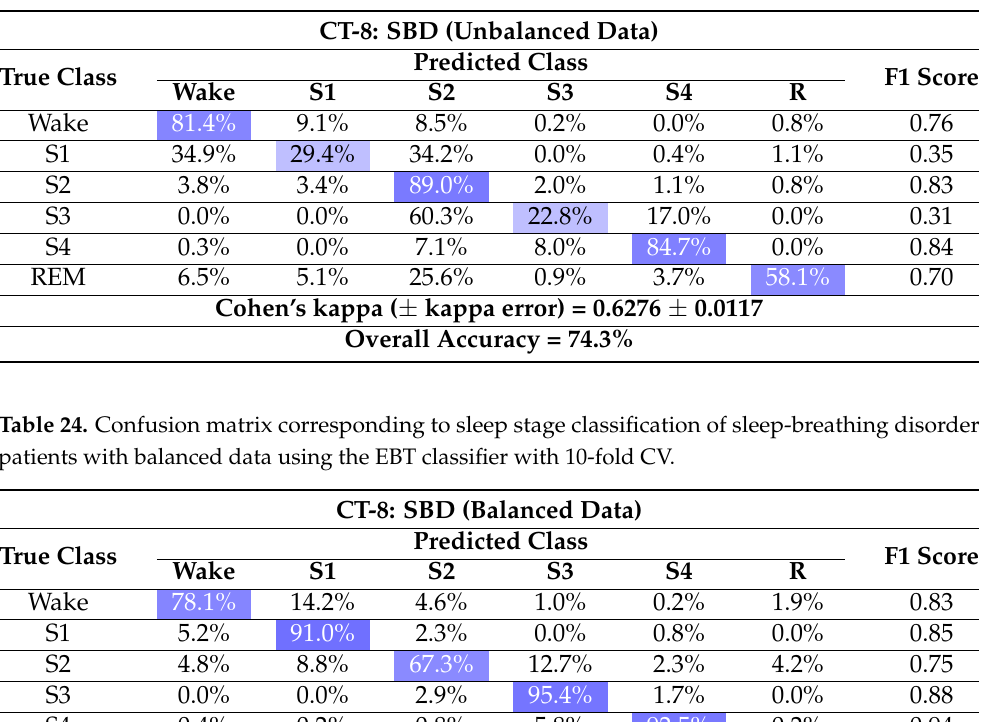
Table 23. Confusion matrix corresponding to sleep stage classification of sleep-breathing disorder patients with unbalanced data using the EBT classifier with 10-fold CV.